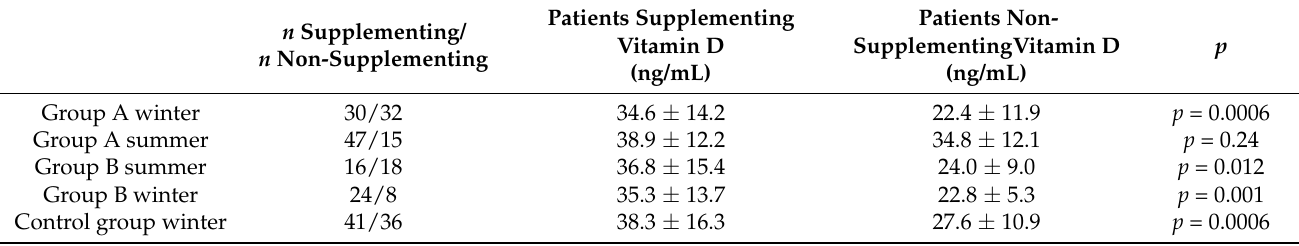
Figure 2. Percentage of women with vitamin 25(OH)D concentrations below the reference value range, with suboptimal and optimal values in Group A—women treated for breast cancer tested the first time in winter; testing during winter—left disc, testing during summer—right disc. ( A ), Group B—women treated for breast cancer tested the first time in summer; testing during winter—left disc, testing during summer—right disc ( B ), and the control group ( C ) (testing during winter only). Table 1. Average 25(OH)D concentration in women treated for breast cancer and in healthy persons in relation to vitamin D supplementation and